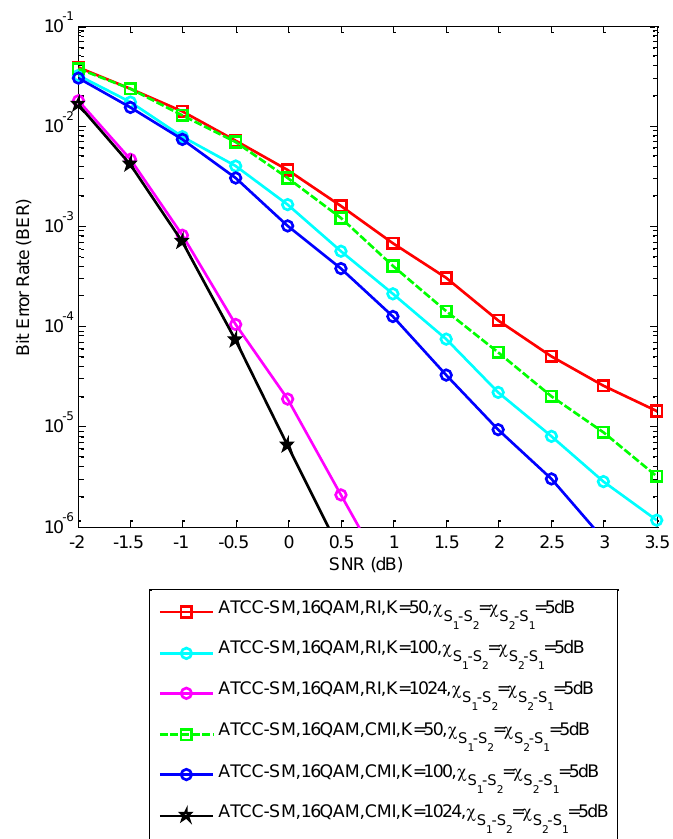
Figure 13. BER performance of two-source ATCC-SM based on the CMI and the RI under a non-ideal inter-user channel scenario over the slow Rayleigh fading channel, 16QAM, N r = N t = 8 , and information length such as K = 50, 100 and 1024.